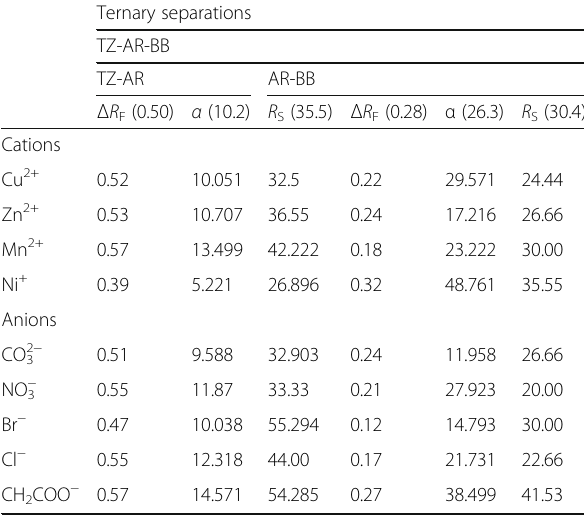
resolution ( R S ) factors of the separation of ternary mixtures of dyes